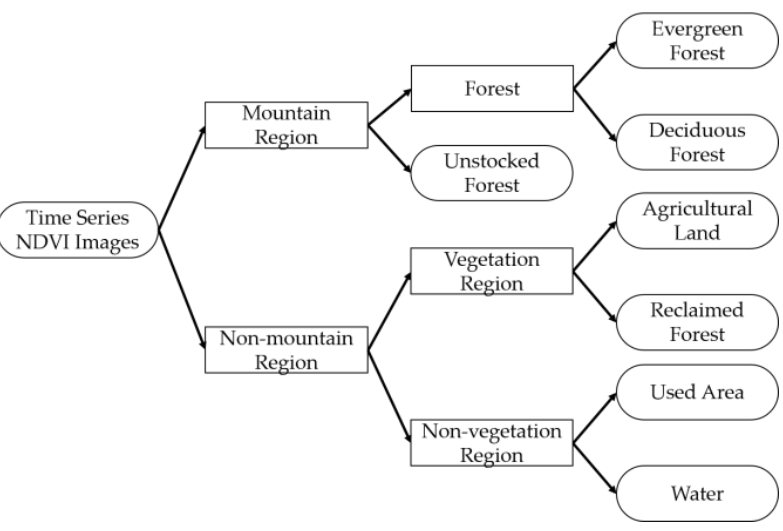
Figure 6. Stepwise classification process.